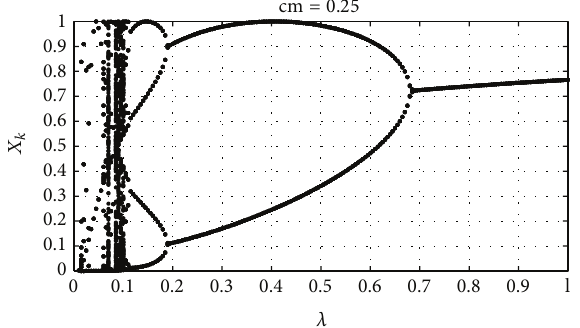
Figure 5: Bifurcation diagram of (3) setting cm = 0.25